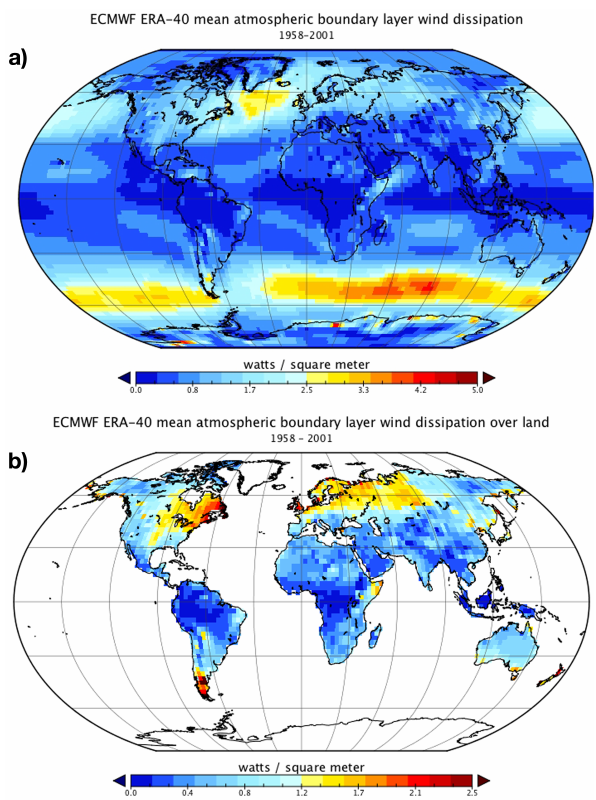
Fig. 2. Distribution of estimated boundary layer wind dissipation a) globally and b) over non-glaciated land as a proxy for wind power extractability from ECMWF ERA-40 reanalysis data.